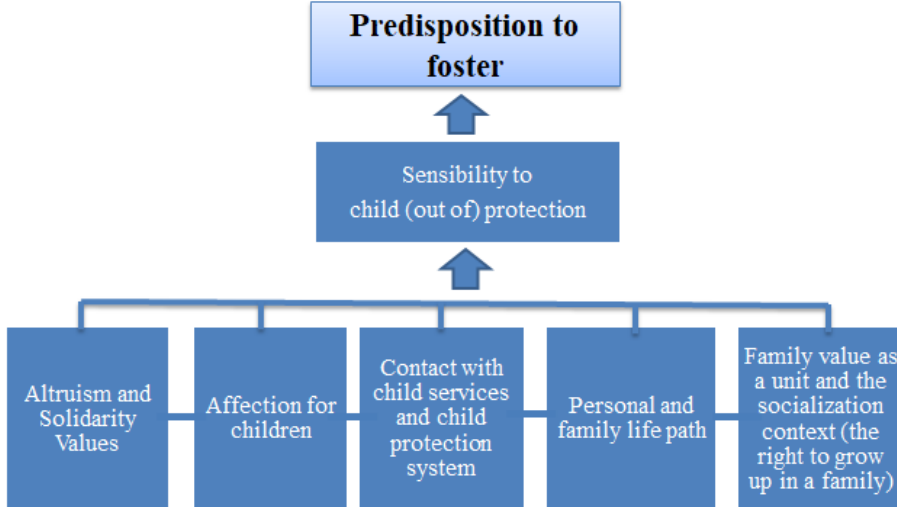
Figure 1. The Producer Factors of the Motivation to become a Foster Family.